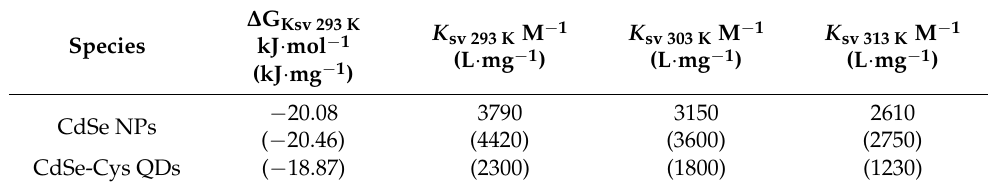
Table 1. Values of Gibbs free energy and quenching constant for the reaction of H 3 L with CdSe NPs and CdSe-Cys QDs.